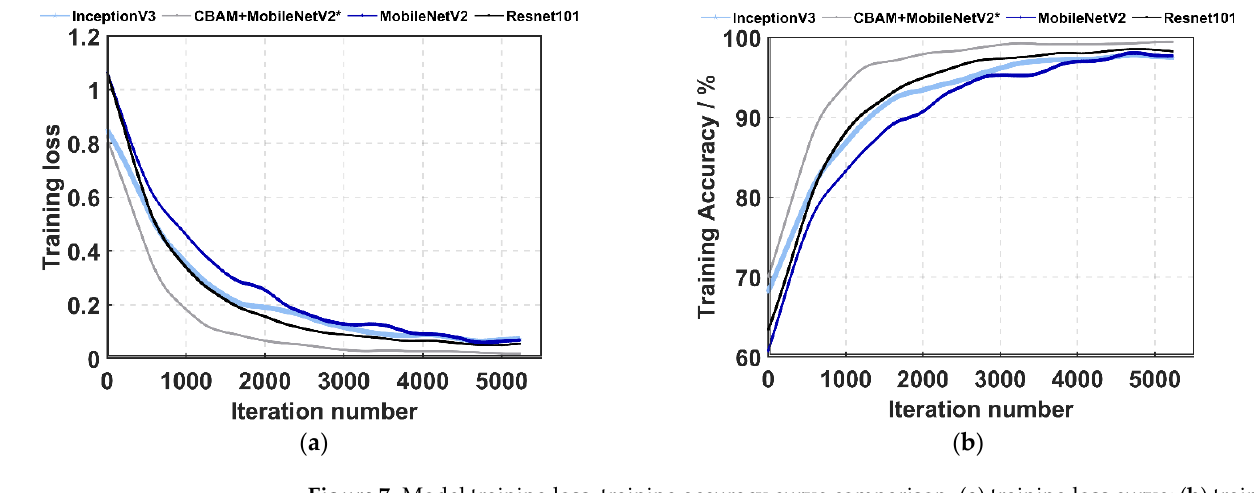
Figure 7. Model training loss, training accuracy curve comparison. ( a ) training loss curve; ( b ) training accuracy curve. Table 4. Model performance comparison